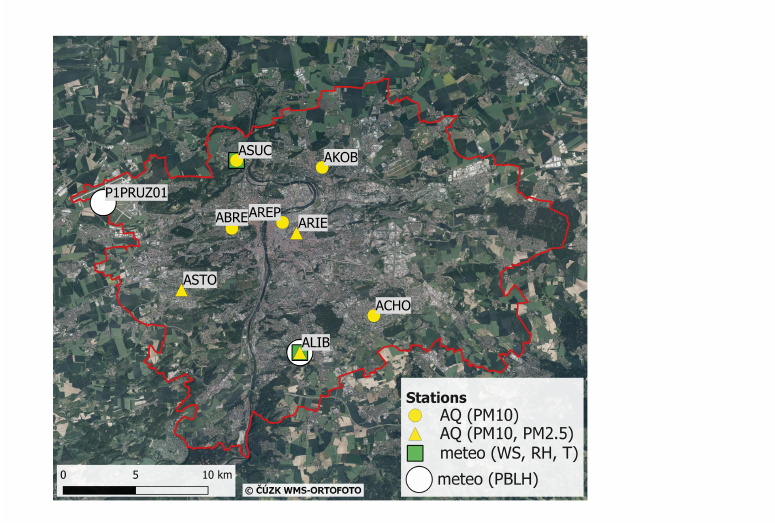
Figure 1. The locations of the observation sites in Prague used for evaluation of Air Quality (AQ) and meteorological (meteo) results. The labels show the code name of each